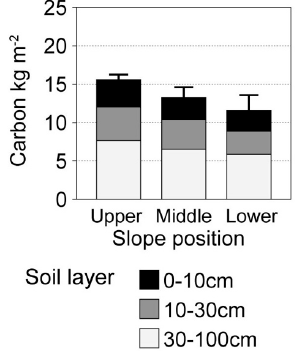
Figure 2. Mean soil carbon stocks in the soil layers at different slope positions in a mixed deciduous forest. The vertical bars represent the standard deviations of the total stocks. The p value of the analysis of variance for the total carbon stocks was 0.03.